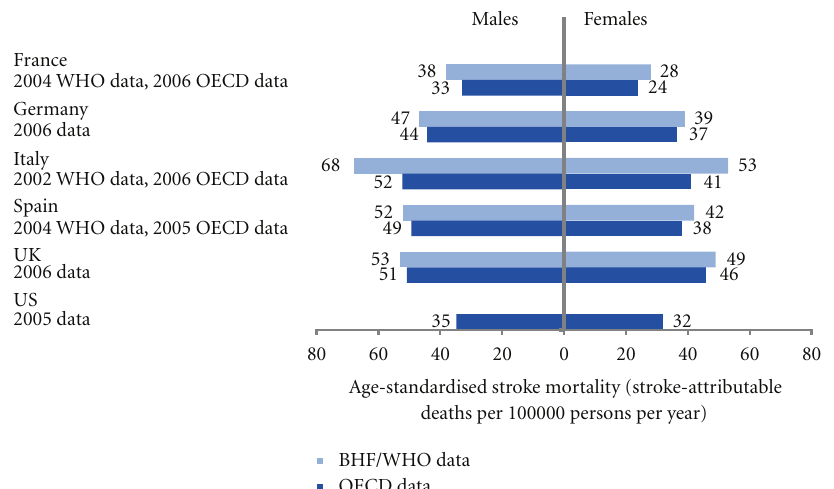
Figure 3: Age-standardised mortality attributable to stroke. BHF: British Heart Foundation, OECD: Organisation for Economic Co- operation and Development, UK: United Kingdom, US: United States, WHO: World Health Organization. Sources: [16,